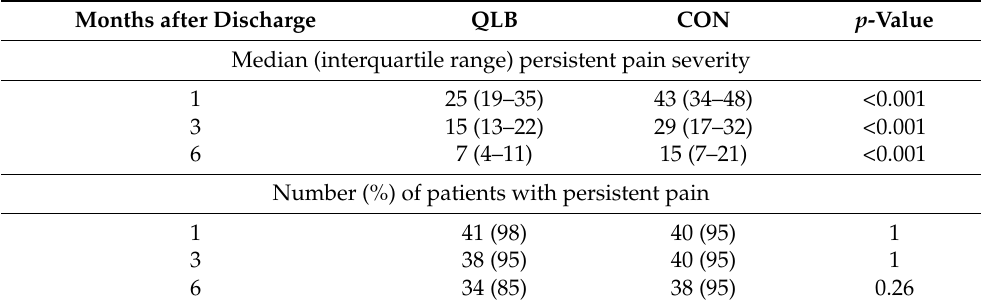
Table 4. Patients with chronic postoperative pain and pain severity measured with the NPSI by study group.